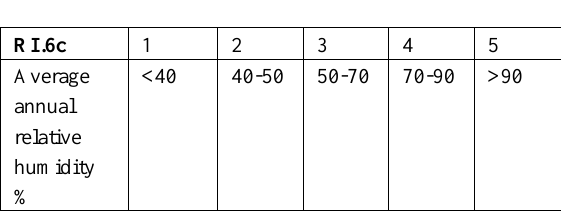
Table 9. Temperature range (around 0 ο C)